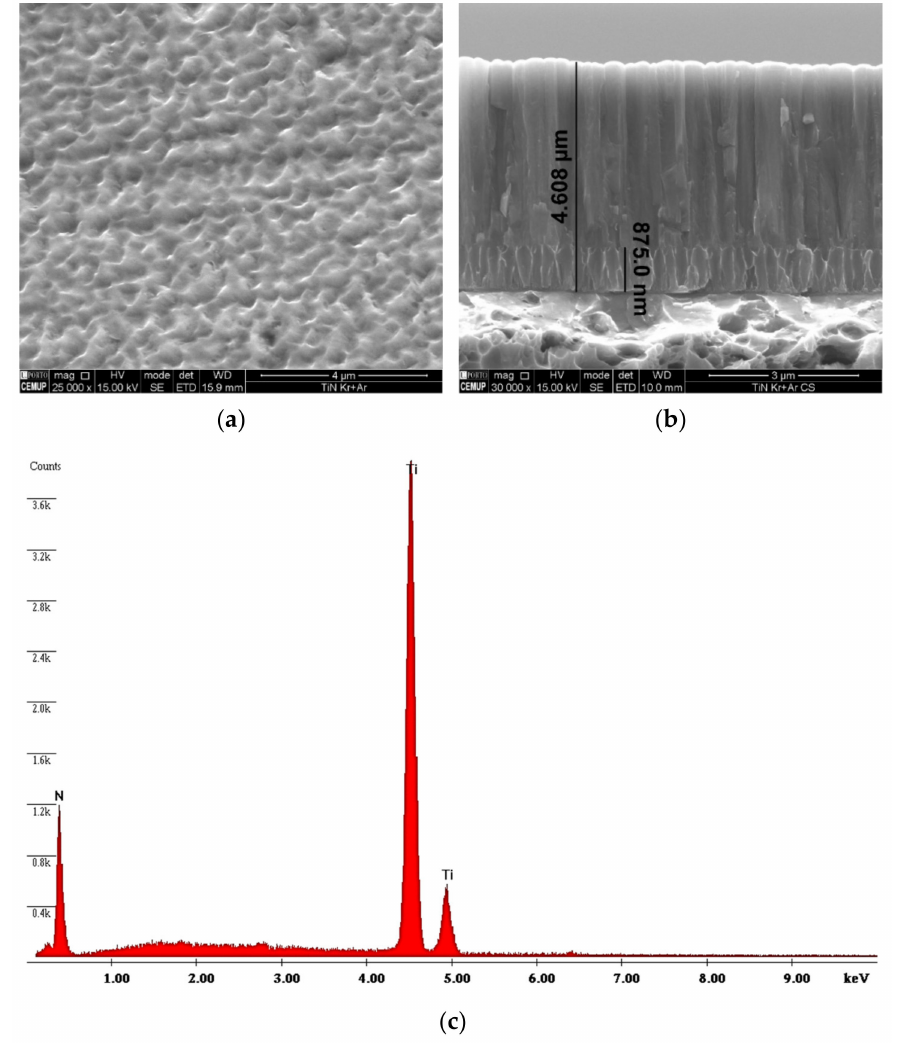
Figure 5. Morphological characterization of the film: ( a ) surface, ( b ) cross-section, ( c ) EDS